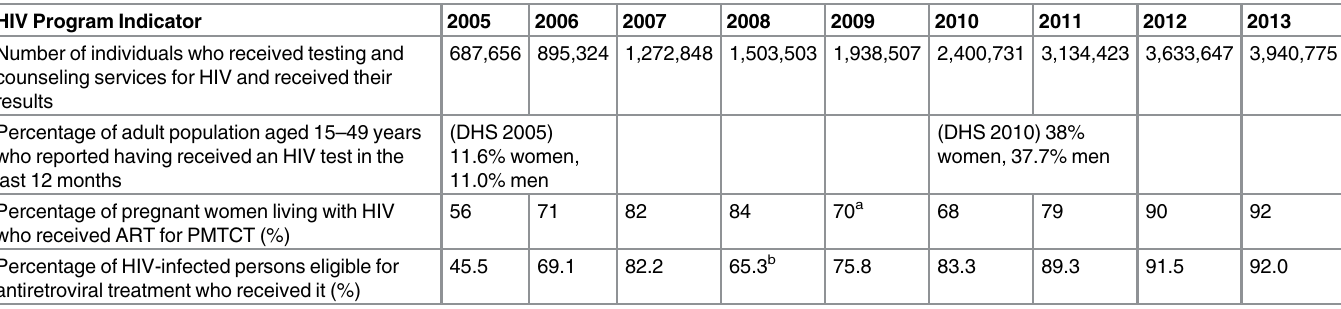
Table 1. Key HIV Program Indicators in Rwanda, 2005 –